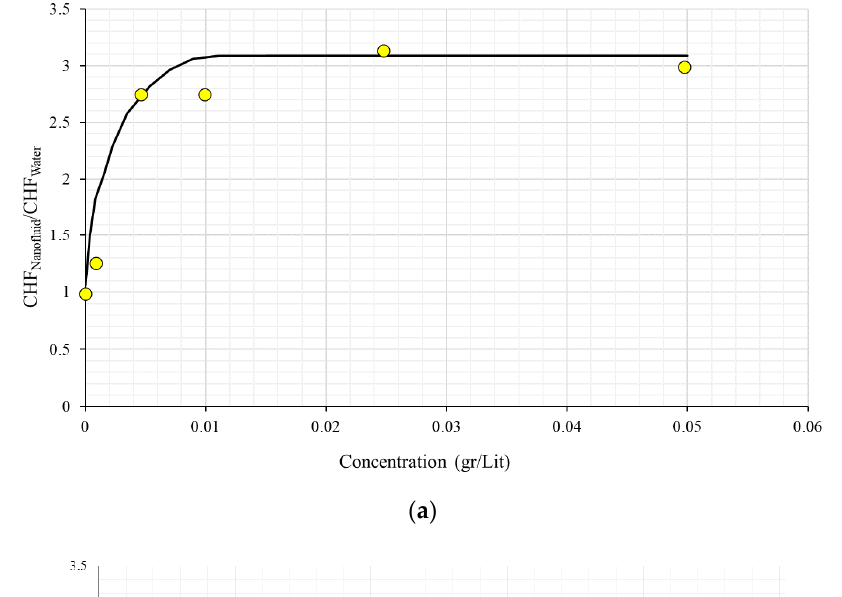
18 of 50 Figure 9. AFM images for (a) polished surface prior to boiling Ra = 5.1 nm and (b) surface after boiling 0.02 vol.% nanofluid, Ra = 376 nm. Adapted from Ciloglu and Bolukbasi. Reproduced from [77], Elsevier: 2015. As was obvious from Figure 10, a significant impact of nanofluid concentration on CHF